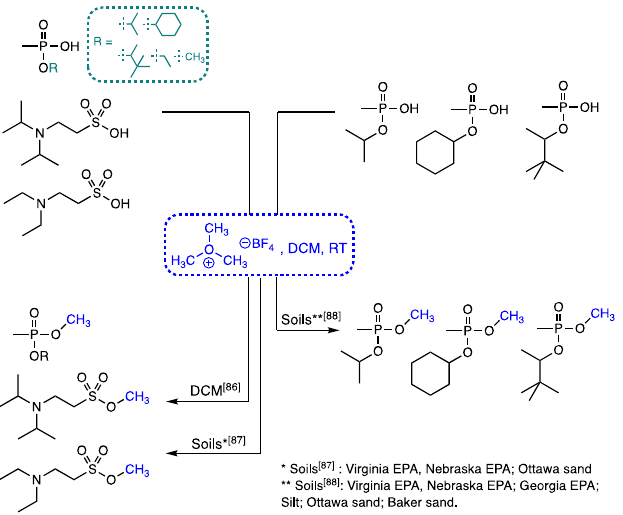
Figure 4. Derivatization approach using trimethyloxonium tetrafluoroborate (TMO) to methylate phosphonic and sulfonic acids related to OPNAs developed in our laboratory.